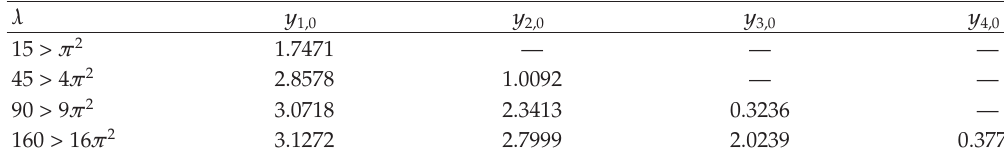
Table 1: Corresponding to the initial values y 1 , 0 , y 2 , 0 , y 3 , 0 , and y 4 , 0 for various λ obtained from (cid:2) 2.54 (cid:3) and (cid:2) 2.55 (cid:3)